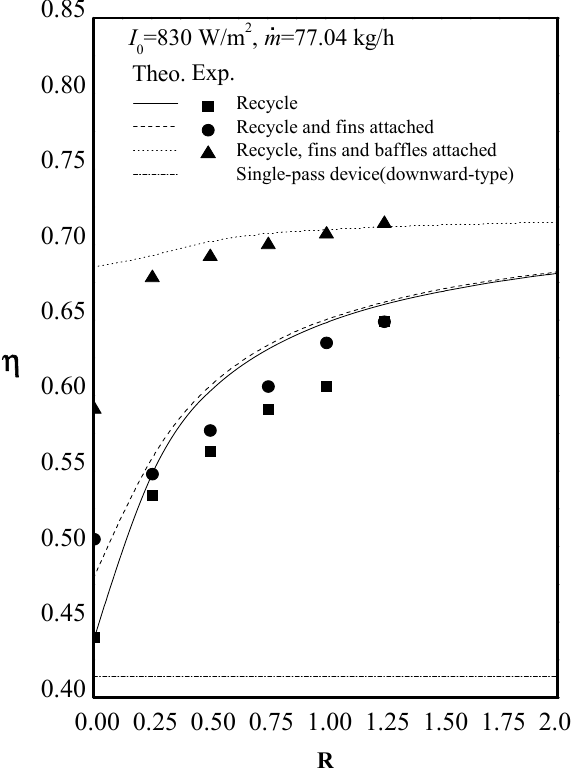
Figure 6. Effect of recycle ratio on collector efficiency in a double-pass flat-plate solar air heater with recycle; I = 830 W/m 2 , m  = 77.04 kg/h. 0